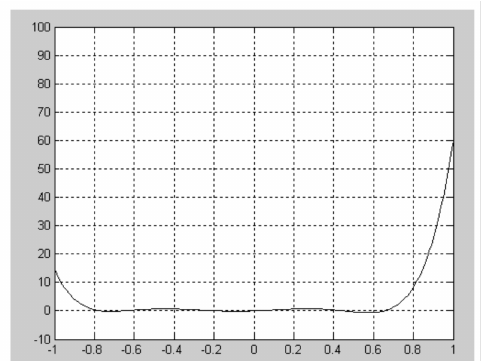
Figure 4. Dependence on the specified dimensional range of the cutting edge and non-negativity of the width of the operating device ( y ( x ) > 0; y (1) = l